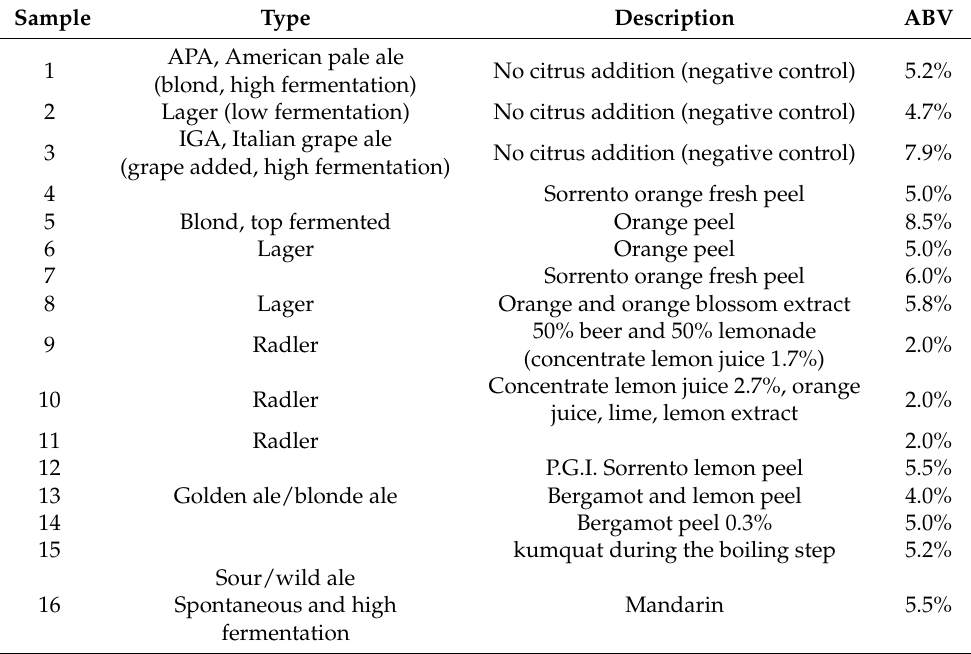
Table 1. Samples analyzed. ABV, alcohol by